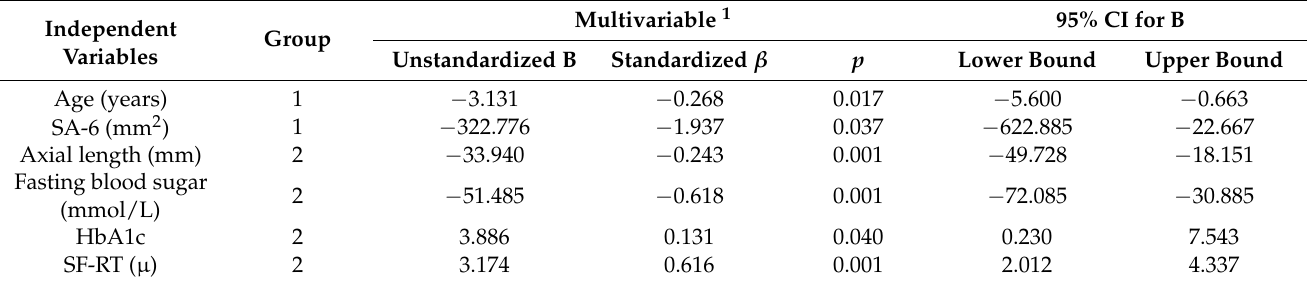
Table 7. Multiple linear regression analysis of factors associated with subfoveal choroidal